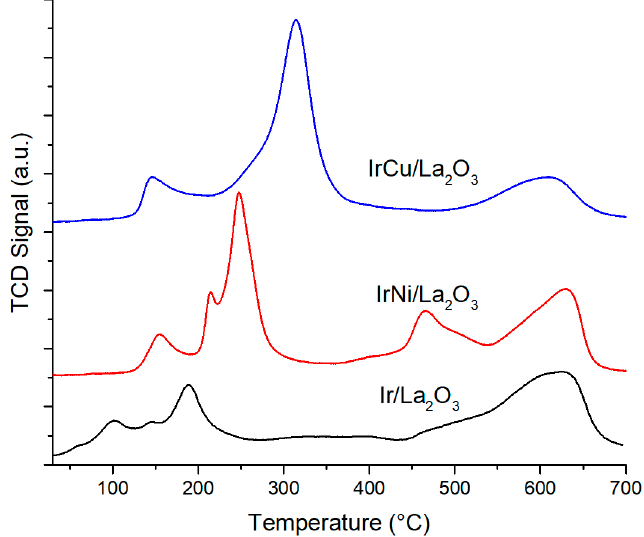
Figure 10. La 2 O 3 -supported catalysts TPR profile.